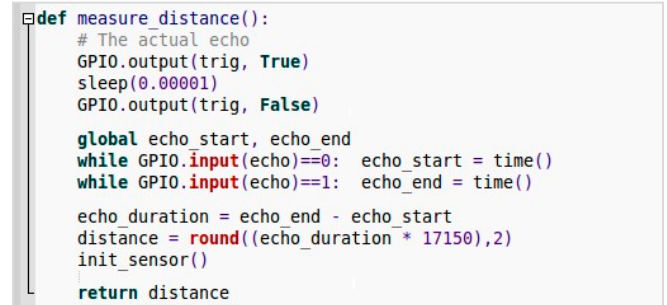
Figure 10. Code Excerpts: using sensor data to measure water level.